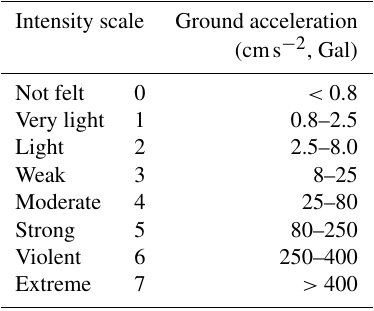
Table 3. Seismic intensity scale of CWB. Intensity